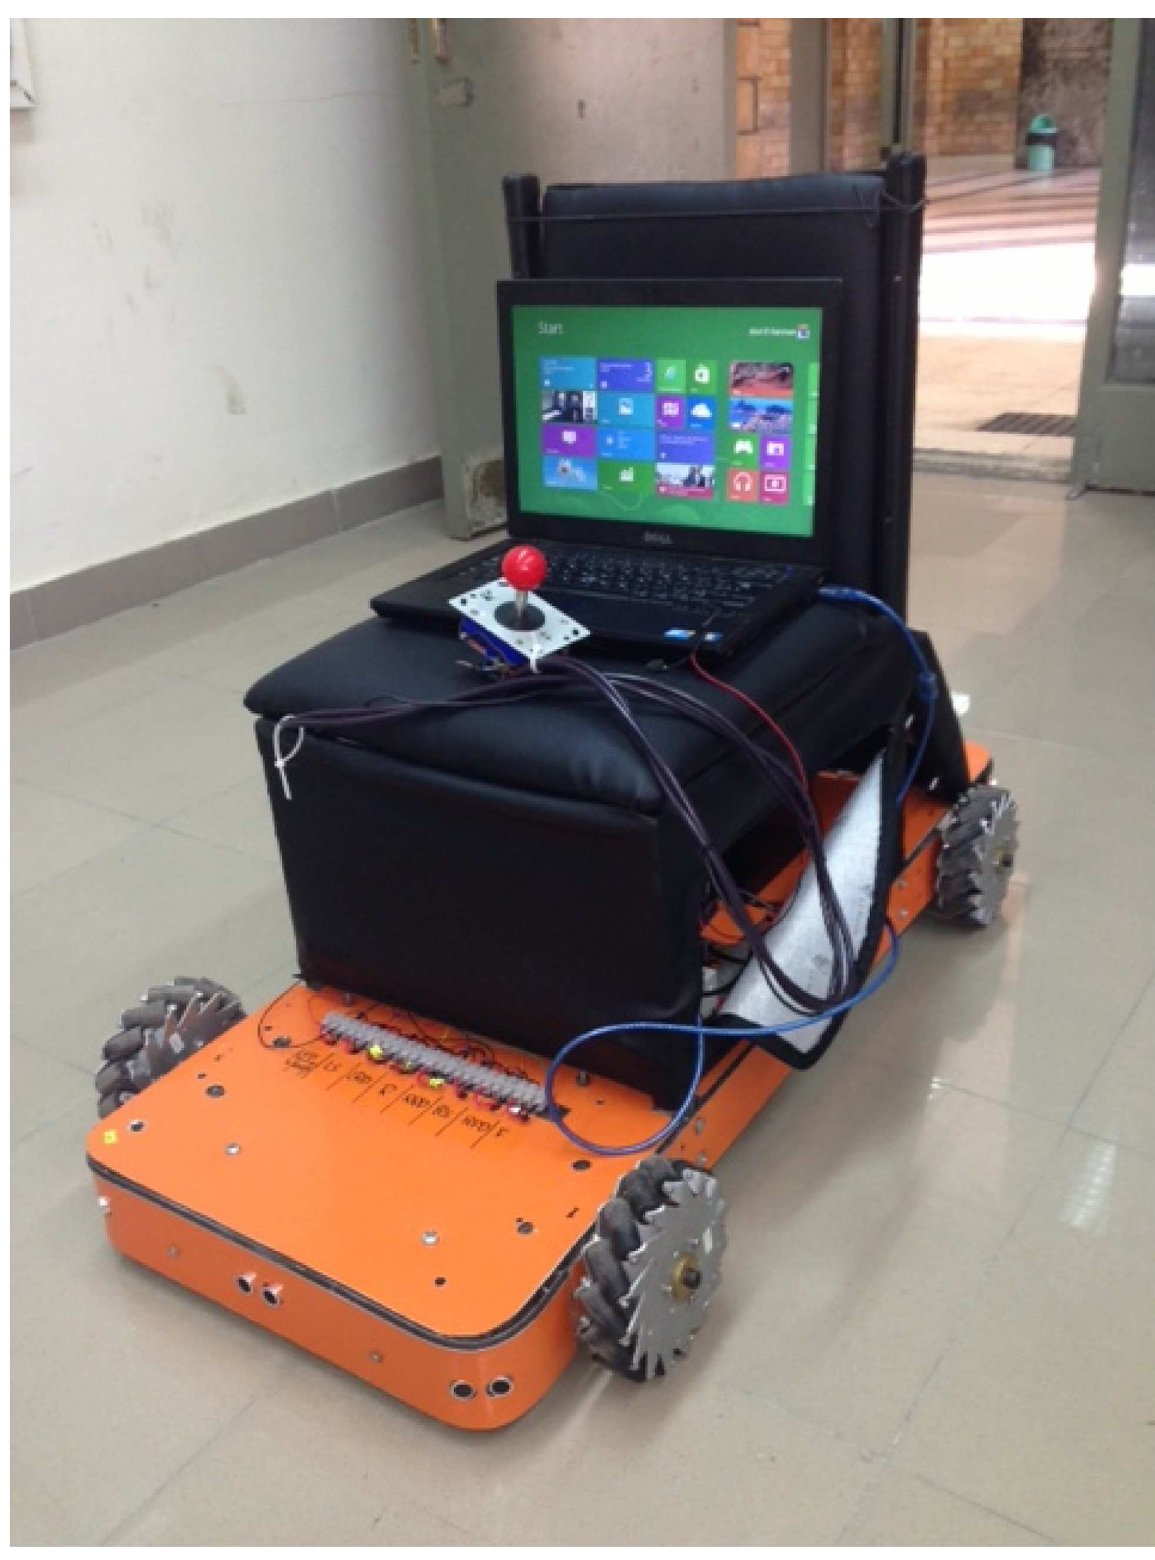
Fig 2. The Chair Real-Time Setup.